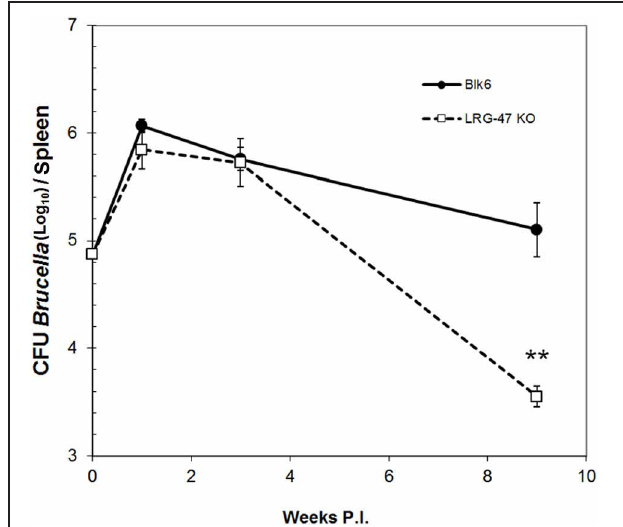
FIGURE 5 | Murine model of chronic brucellosis. Transgenic LRG-47 − / − mice and C57/B6 mice were infected intraperitoneally with 1 × 10 5 CFU of B. abortus 2308. Values represent the average and standard deviation of CFU’s enumerated from a minimum of 5 mice per group ( ∗∗ p ≤ 0 . 01 Student’s t -Test). Separate experiments that included 129/B6 F2 mice yielded similar results of no defect spleen colonization before 4 weeks post infection for any group tested, including LRG-47 KO mice. LRG-47 CONTRIBUTES TO STABILITY OF CHRONIC BRUCELLOSIS IN